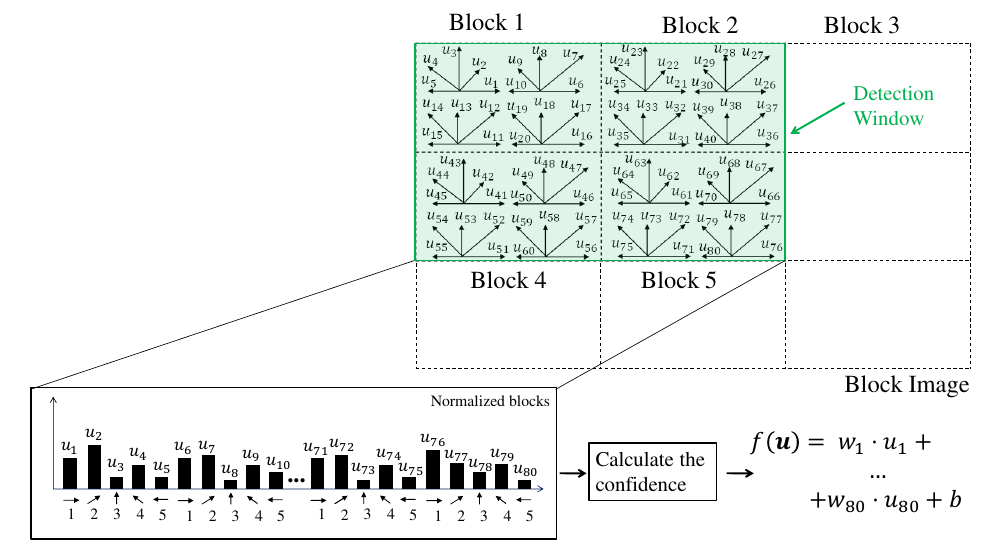
Figure 4. Example of the SVM function used inside a detection window. Each feature u corresponds to the frequency of its respective bin in the block